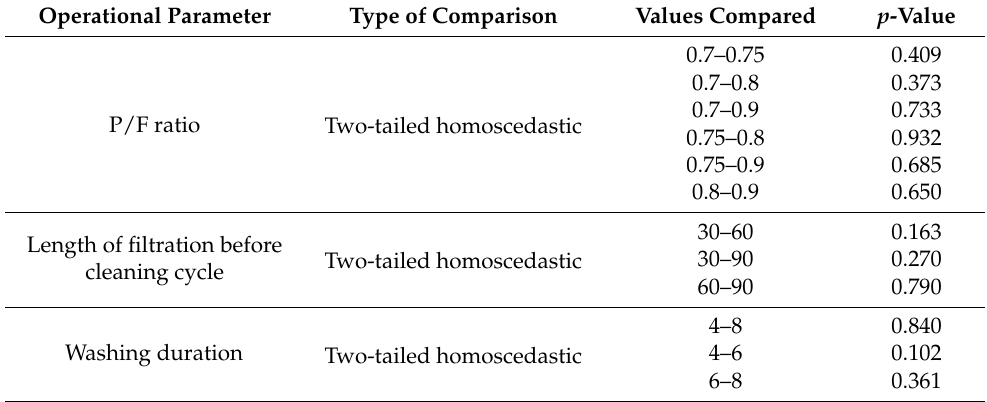
Table A1. Statistical analysis ( t -test) of the effect of membrane operational parameters on the permeate COD. Operational